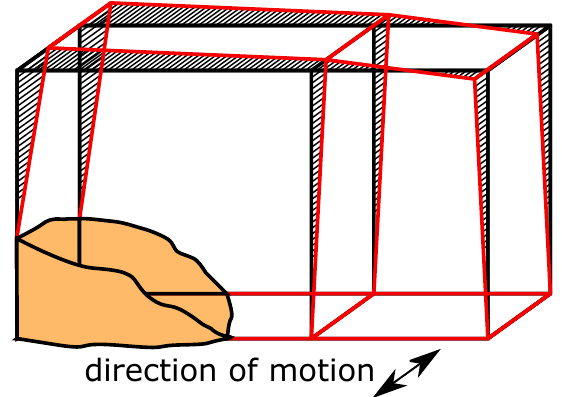
Figure 6. 2 nd modal shapes of 7-story RC-building identified by using FDD.